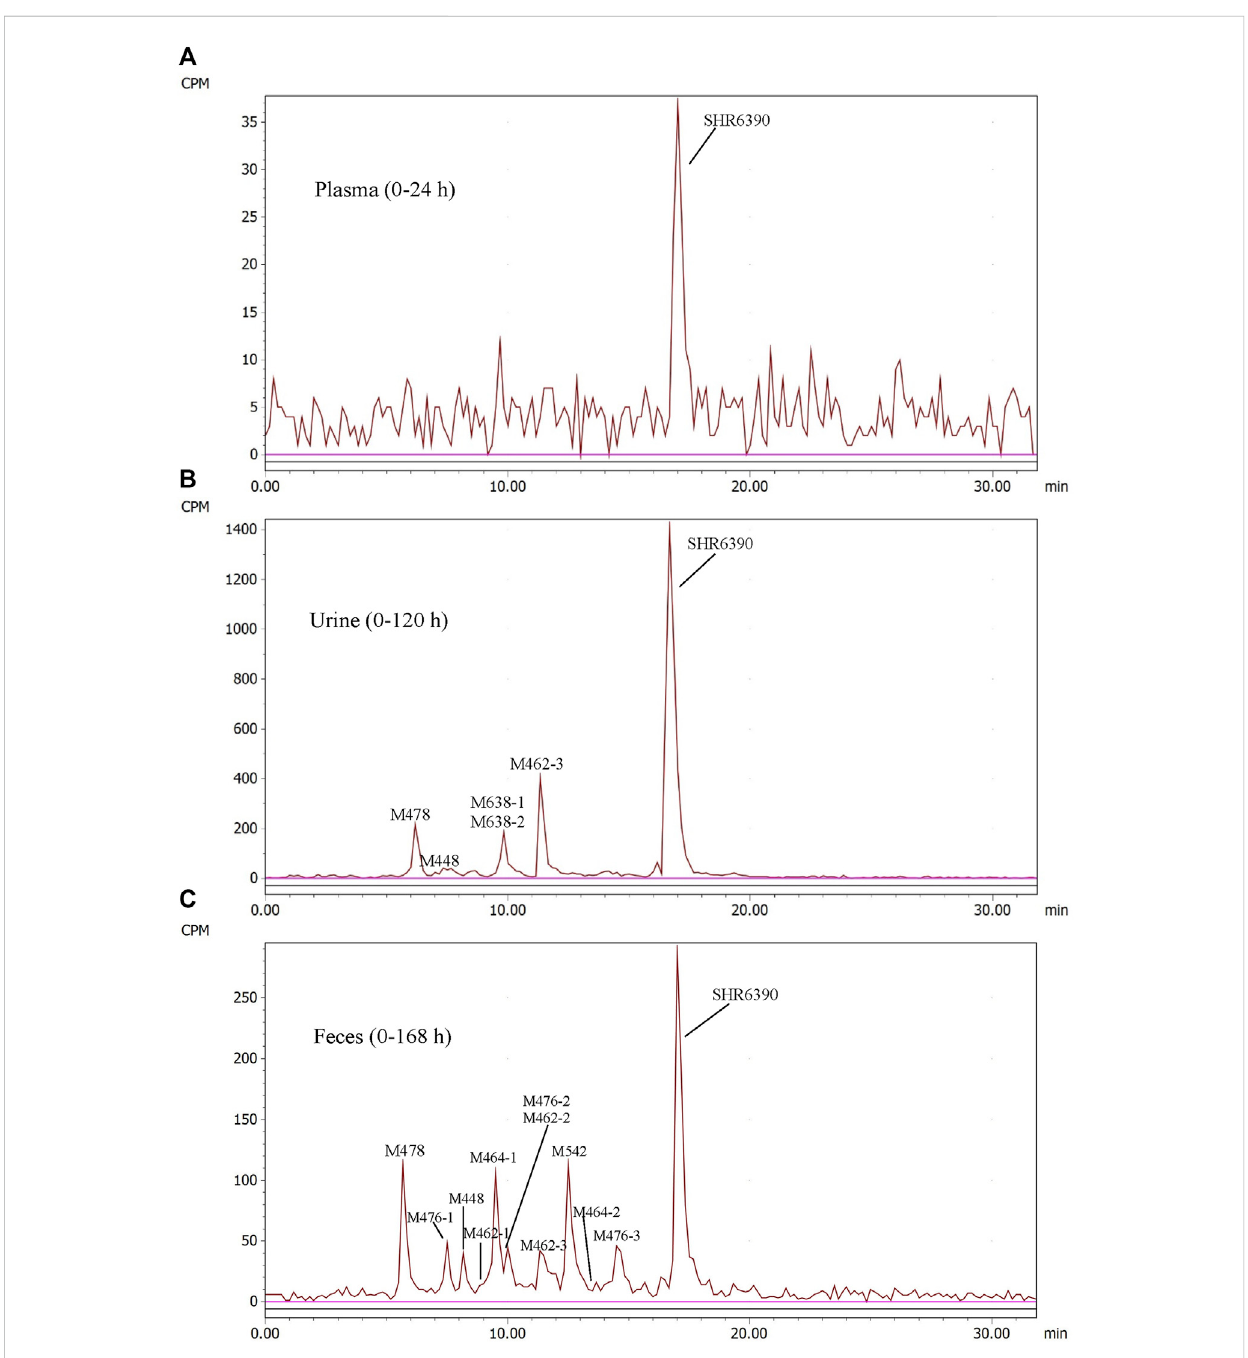
FIGURE 3 Representative radio-chromatograms of metabolites in human plasma (0 – 24 h) (A) , urine (0 – 120 h) (B) , and feces (0 – 168 h) (C) following oral administration of 150 mg [ 14 C]SHR6390 (150 µCi).